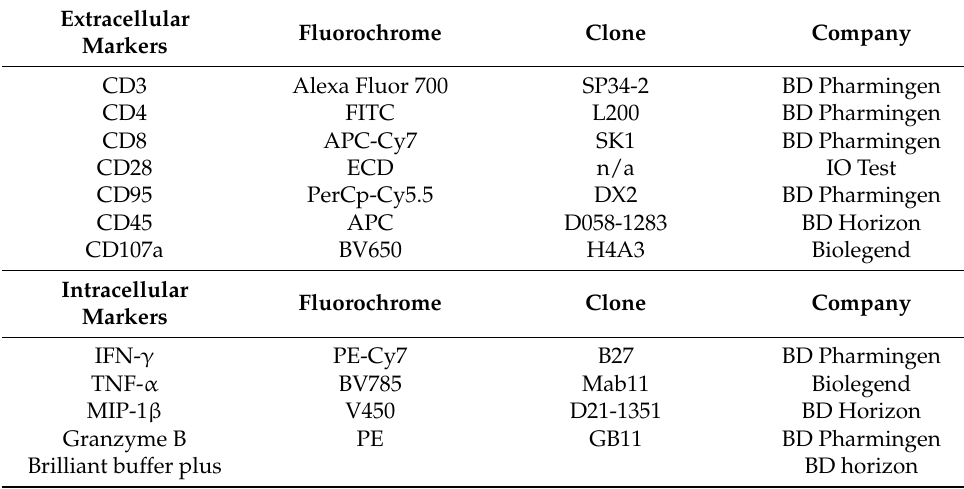
Table 2. Panel of anti-monkey antibodies used for the ICS